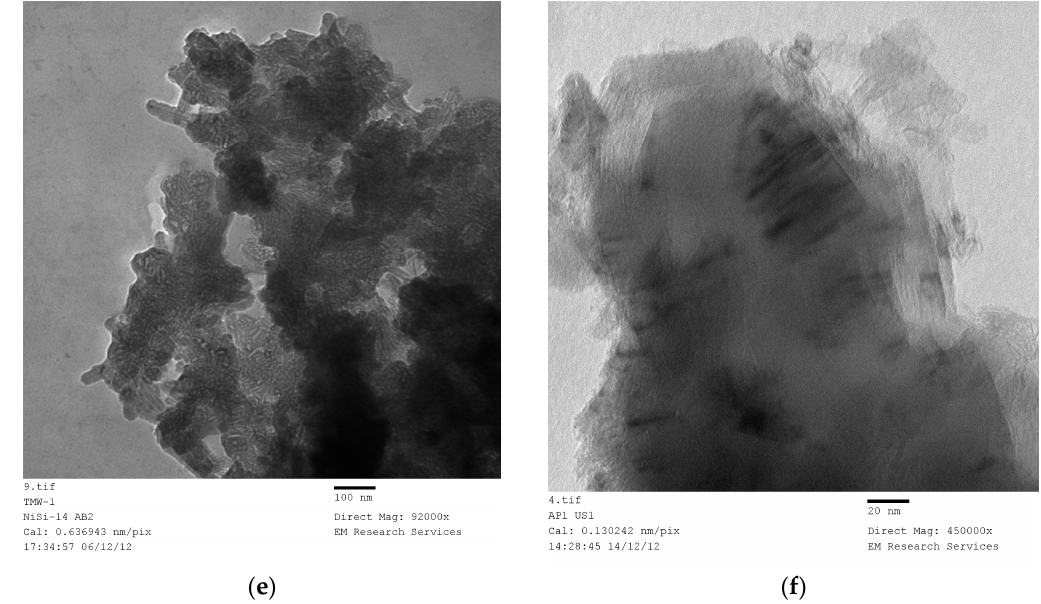
Figure 22. TEM images of several Ni/Si catalysts with varying compositions and processing history. ( a ) Ni/Si = 1/4 Mw ‐ ABCD (Bar = 100 nm); ( b ) Ni/Si = 1/4 Mw ‐ ABCD (Bar = 20 nm); ( c ) Ni/Si = 1/4 Mw ‐ ABCD (Bar = 20 nm); ( d ) Ni/Si = 1/4 Mw ‐ Y pH = 0.2 (Bar = 20 nm); ( e ) Ni/Si = 1/4(Mw+Th) ‐ A+B (Bar = 100 nm); ( f ) Ni/Si = 1/5(Mw+US)-A (Mw = 0.4 kW; US = 0.04 kW) (Bar = 20 nm).